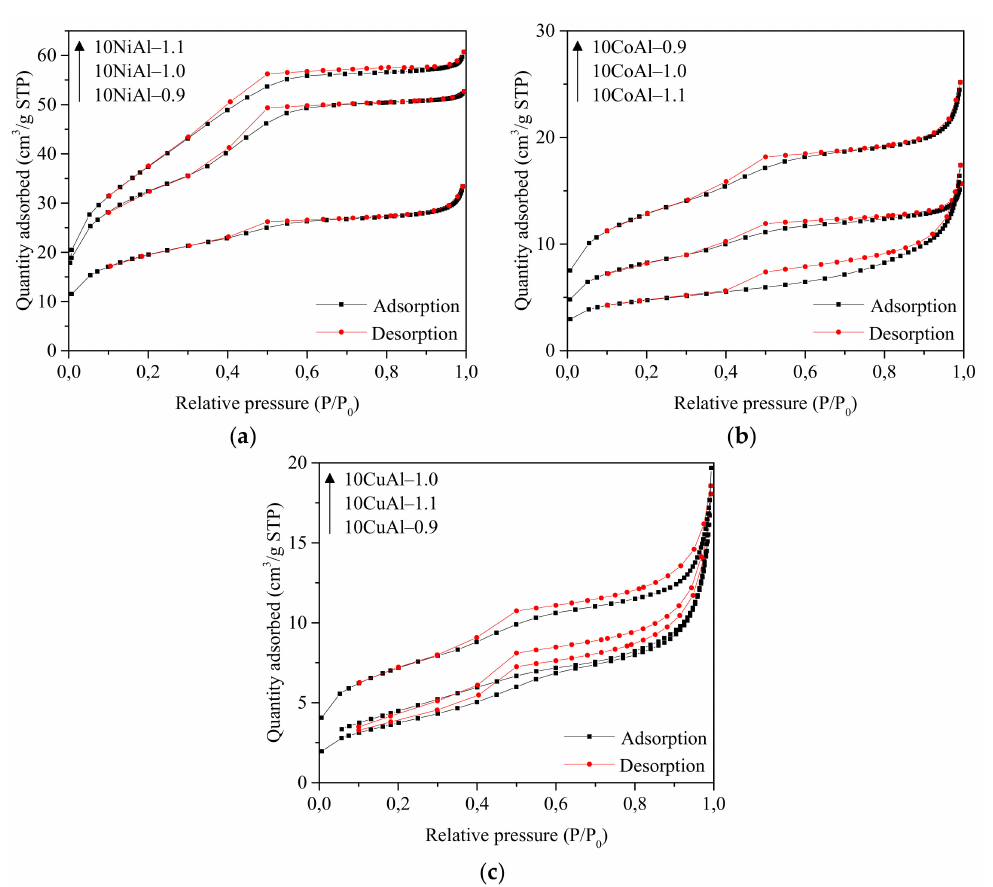
Figure 4. N 2 adsorption-desorption isotherm of ( a ) 10NiAl − x, ( b ) 10CoAl − x and ( c ) 10CuAl − x calcined